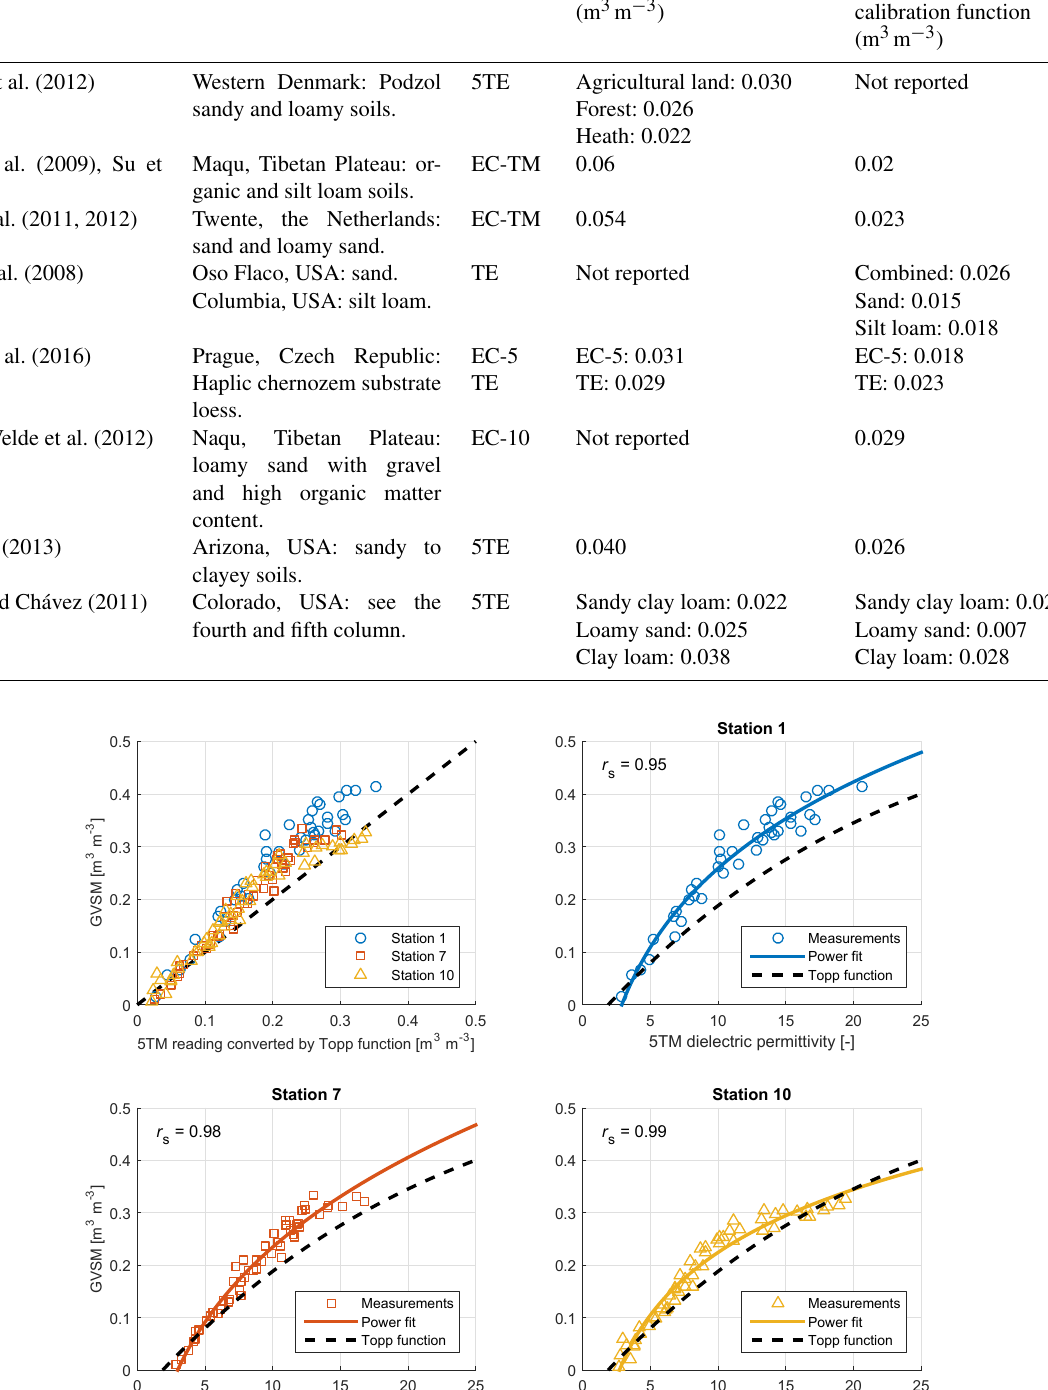
Table 6. Accuracy metrics between GVSMs and readings by various Decagon sensors reported in previous studies. Study